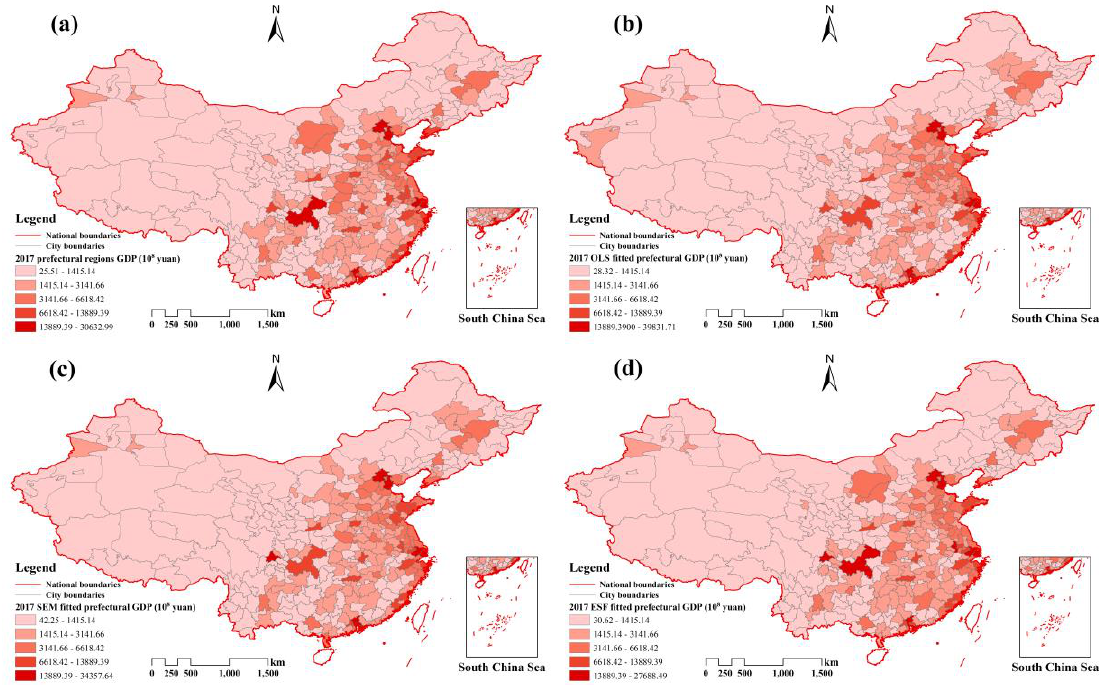
Figure 5. China prefecture GDP map in 2017: ( a ) original GDP distribution. ( b ) OLS fitted GDP distribution. ( c ) SEM fitted GDP distribution. ( d ) ESF regression fitted GDP distribution.